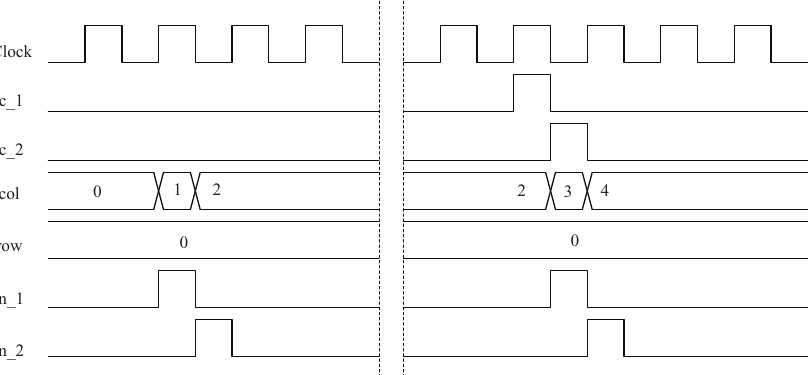
Figure 4. Timing diagram when there are two sets of y 0 and y 1 calculation modules and interpola- tion modules.